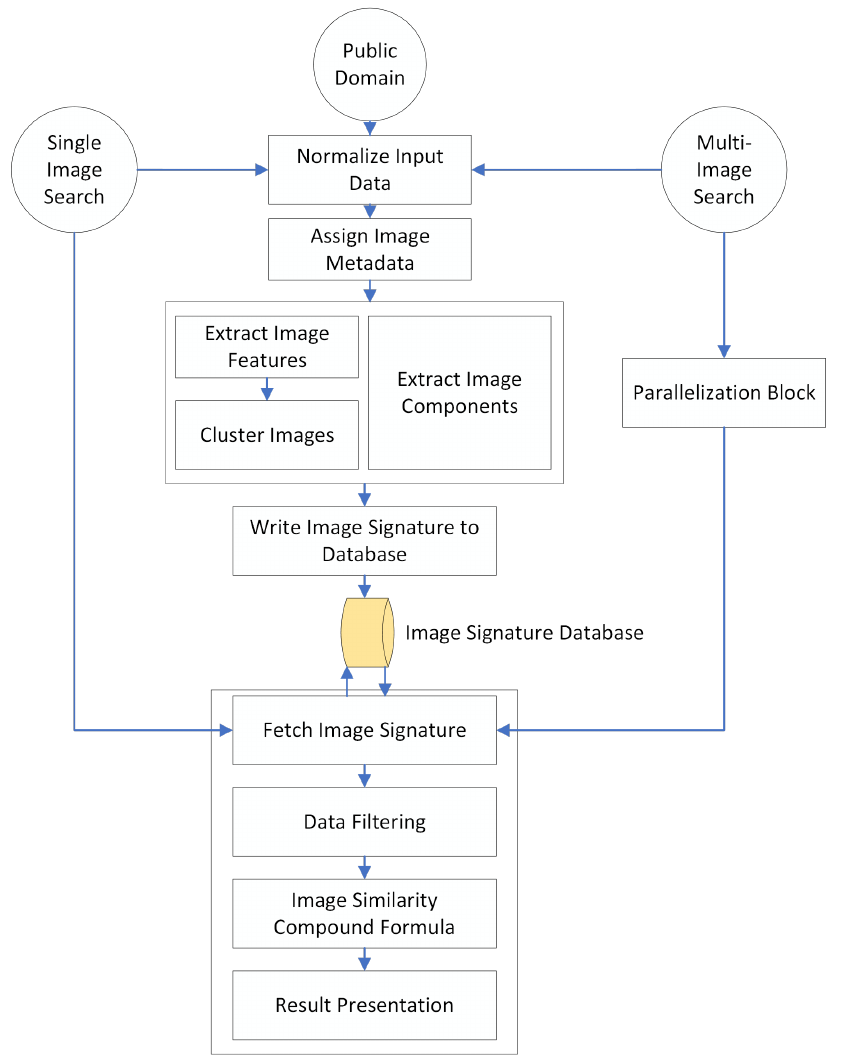
Figure 1. The Darwin graphical search engine workflow diagram.